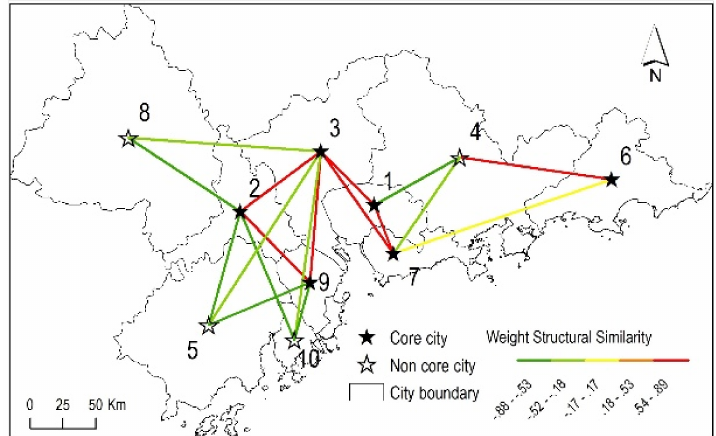
Figure 4. The weighted structural similarity and core nodes in the sample train network.